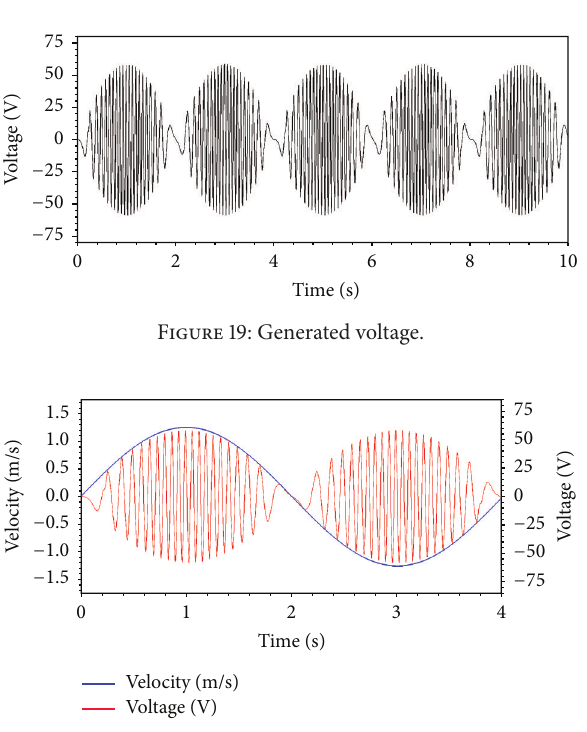
Figure 20: Relation between induced voltage and speed.